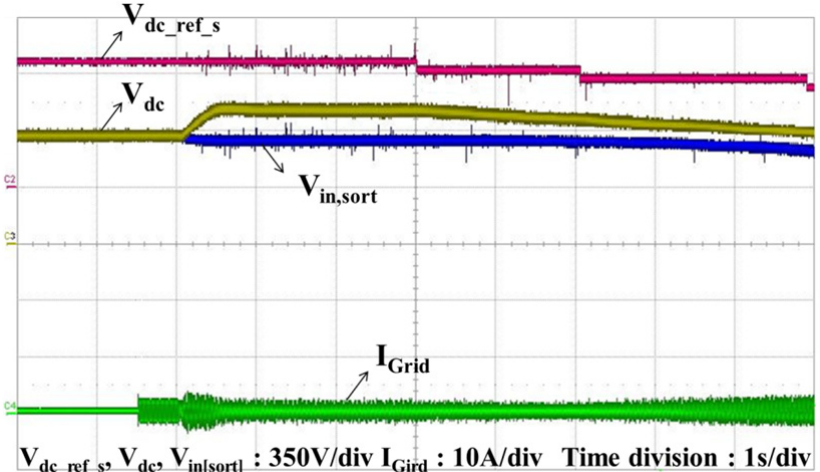
Figure 18. Experimental results for the DC-link voltage, V Figure 11 when the PV system is